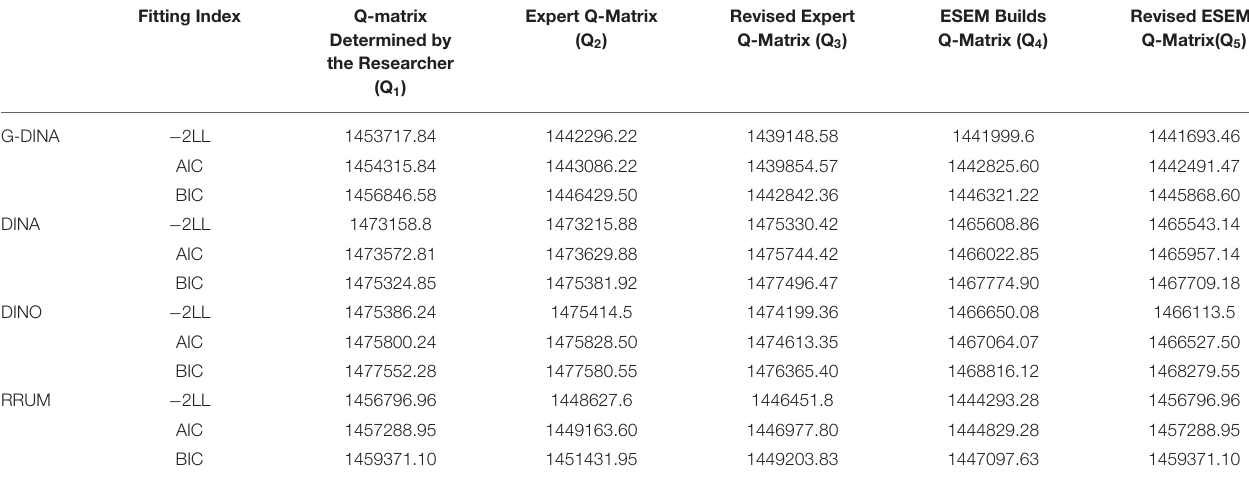
TABLE 4 | Relative fit evaluation index at the test